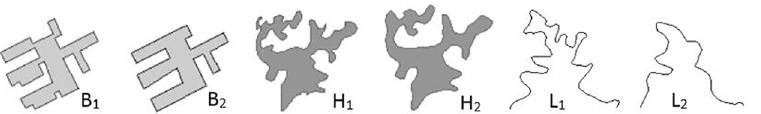
Fig 2. The experimental data. (Group one is building feature with orthogonal boundary. Group two is lake feature with smooth boundary. Group three is linear feature with smooth boundary).